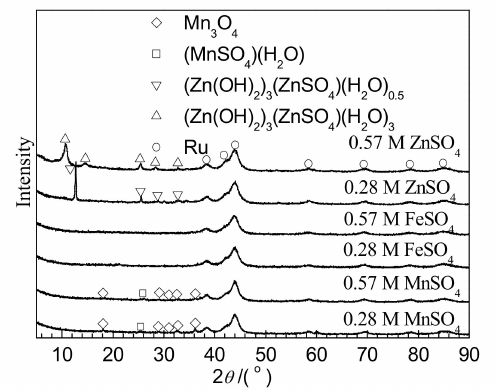
Figure 4. XRD patterns of spent Ru@Mn 3 O 4 (0.46) with 0.28 mol L − 1 as well as 0.57 mol L − 1 of ZnSO 4 , MnSO 4 and FeSO 4 as additives,